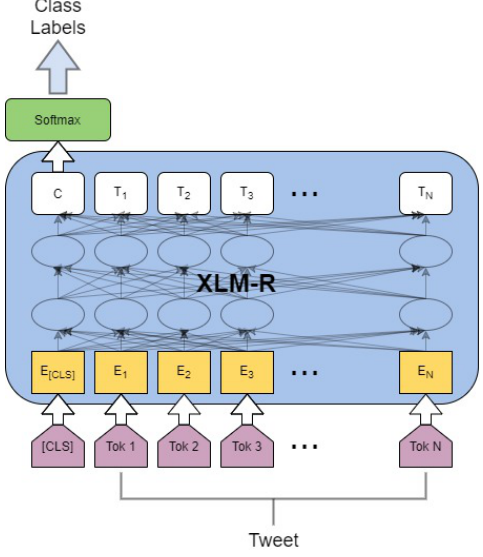
Figure 1. Text classification architecture [8].